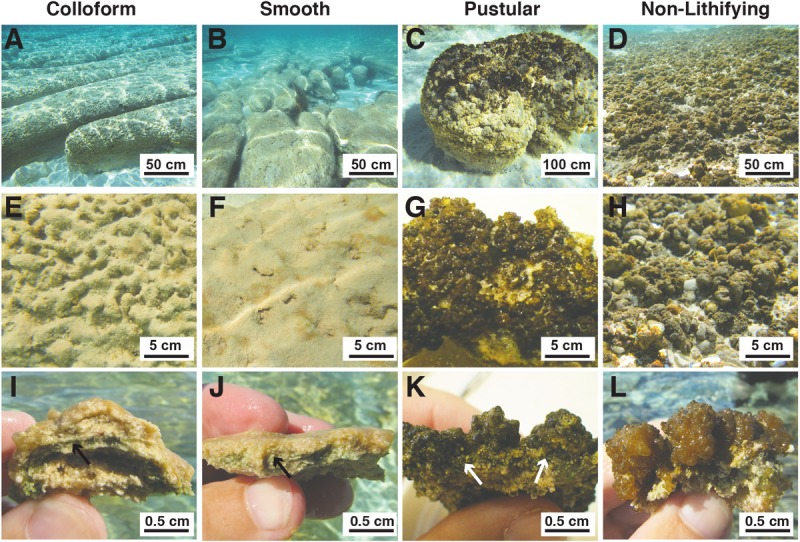
Morphological features of mat types targeted in this study. (A–D) Underwater images depicting the macroscopic morphologies of the elongated nested build-ups associated with the colloform (A) and smooth (B) mat types, as well as the circular carbonate build-ups associated with the pustular (C) stromatolite-forming mats. The non-lithifying pustular mats form extensive sheets within the upper intertidal zone. (A,B) Bar = 50 cm; (C,D) Bar = 100 cm. (E–H) Surface images of the mat types showing the convoluted colloform (E), flat smooth (F), and nodular surfaces of the lithifying (G) and non-lithifying (H) pustular mats. Bar = 5 cm. (I–L) Cross-section of the mat surfaces depicting the domal structure of the colloform mat (I), flat surfaces of the smooth mats (J), heavily pigmented nodular structure of the lithifying pustular mat (K), and lighter pigmentation in the non-lithifying pustular mats (L). Bar = 0.5 cm. Arrows indicate cyanobacterial layer within the stromatolite forming mats.